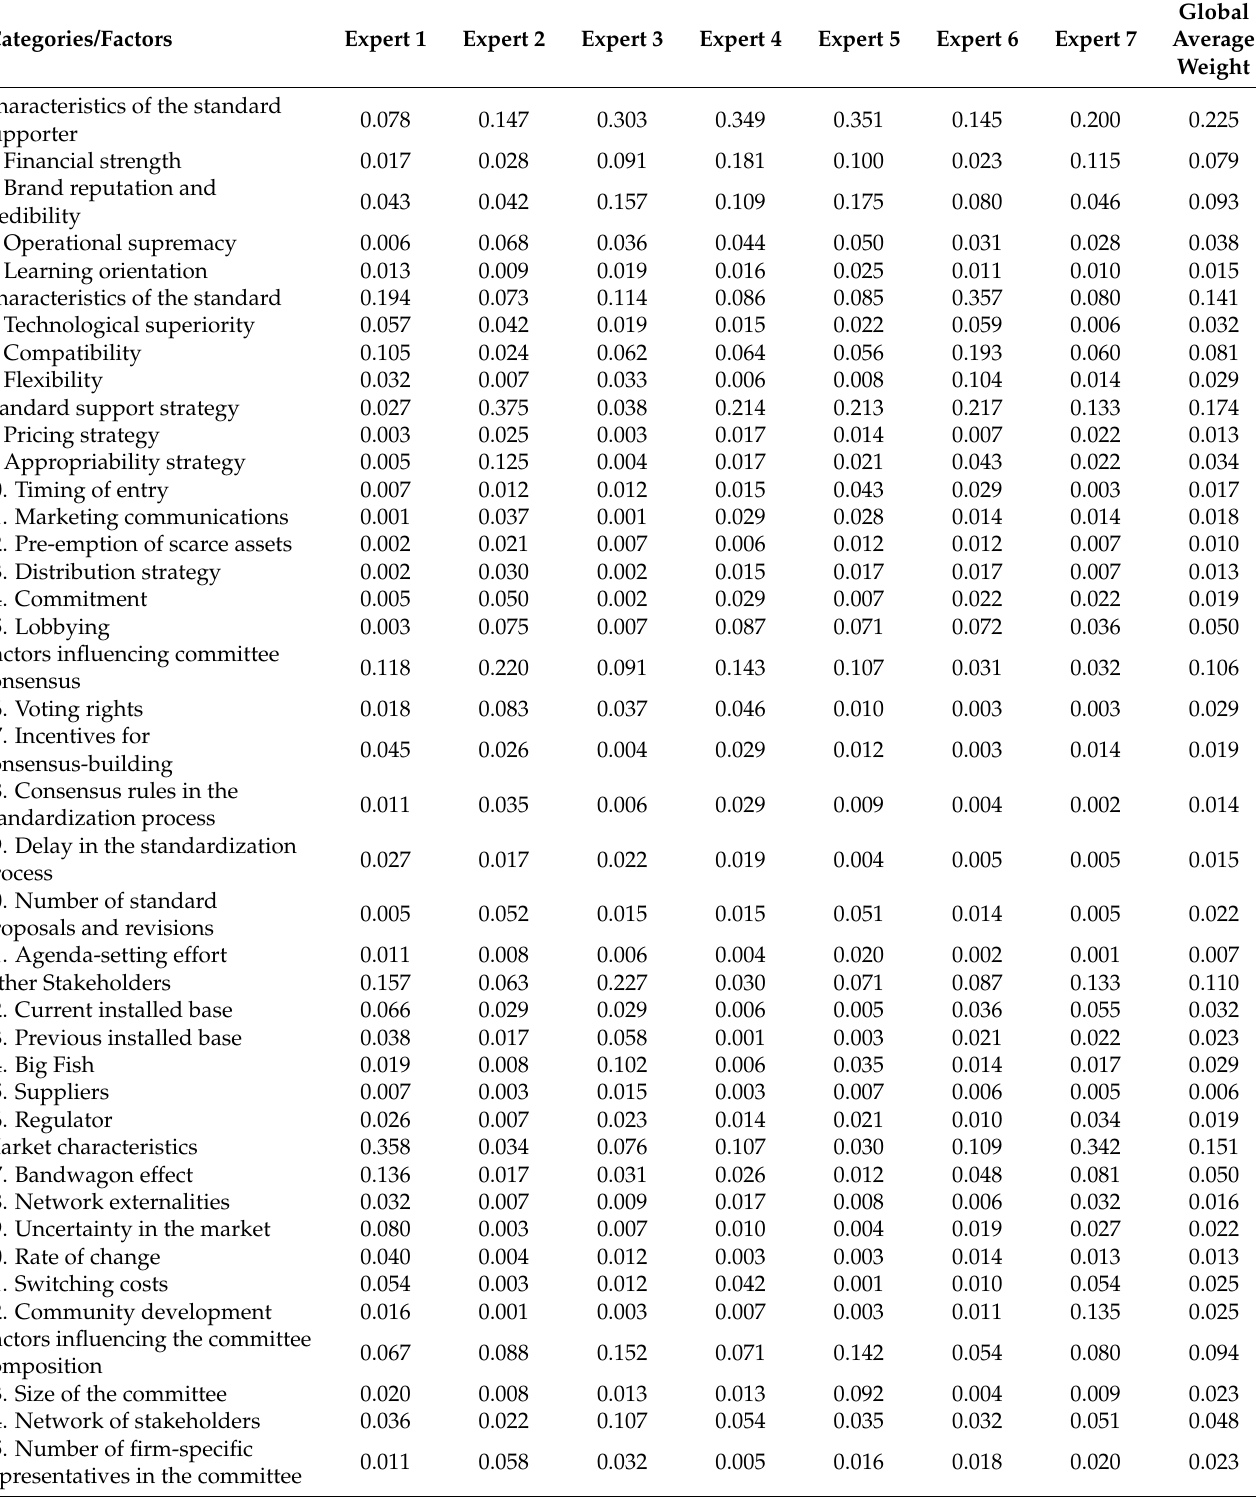
Table 3. Local and global weights per